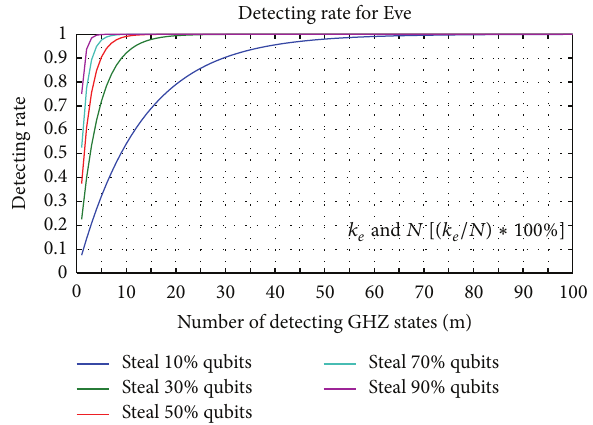
Figure 9: The different percentages of 𝑘 𝑒 in 𝑁 GHZ states corre- sponding to the error detection rate and the number of detecting GHZ states. ( 𝑘 𝑒 : the number of GHZ states replaced by Eve’s EPR pairs; 𝑁 : the number of GHZ states which are prepared from Charlie).